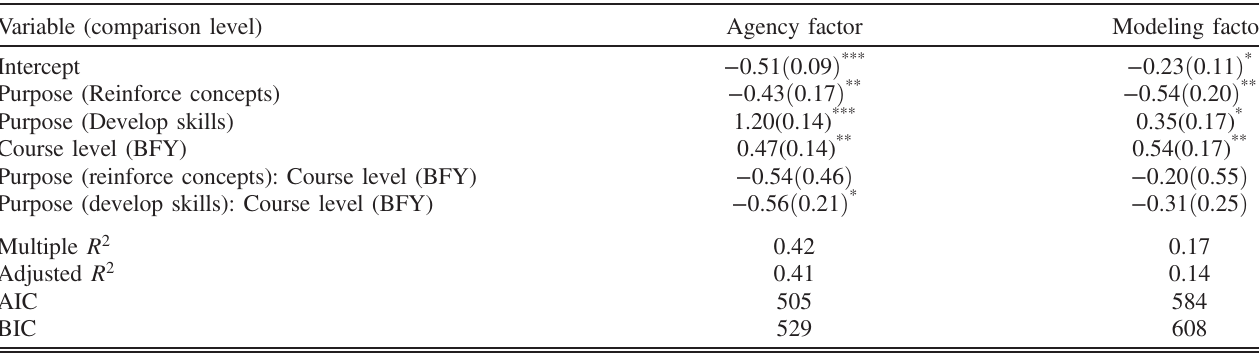
TABLE IV. Regression table indicating effect sizes (and standard errors) for factor scores as a function of course variables. Comparison levels (encoded as 1) are estimated relative to the reference group (FY-level courses aiming to both develop skills and reinforce concepts). Multiple R 2 is approximately the percent variance explained by the model and the adjusted R 2 is adjusted for the number of predictors in the model. The Akaike information criterion (AIC) and Bayesion information criterion (BIC) are fit indices using maximum likelihood estimates that penalize for model complexity (BIC more so than